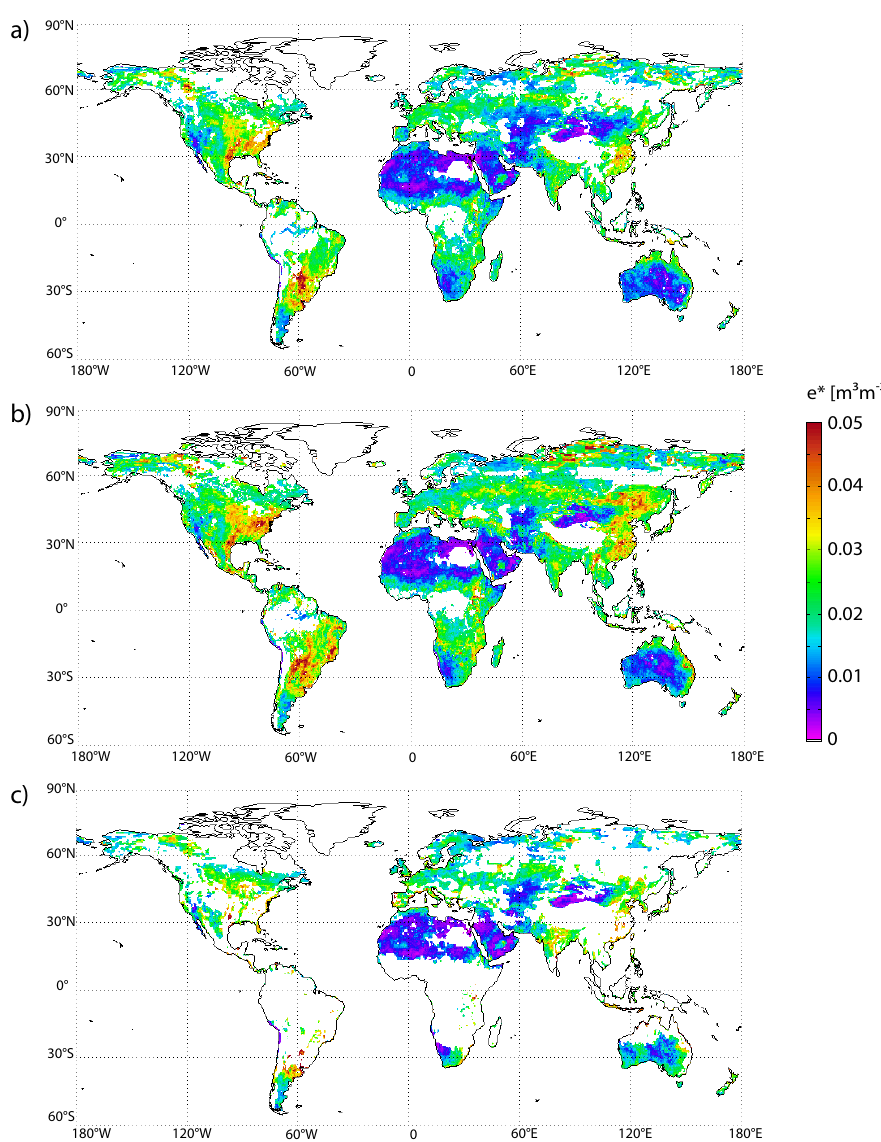
Fig. 2. Spatial errors e ∗ of (a) AMSR-E C-band, (b) AMSR-E X-band, and (c) SSM/I Ku-band observations obtained with triple colloca- PAS tion based on ERA-Interim, ASCAT, and the respective radiometer dataset. Errors are expressed in the climatology of ERA-Interim.